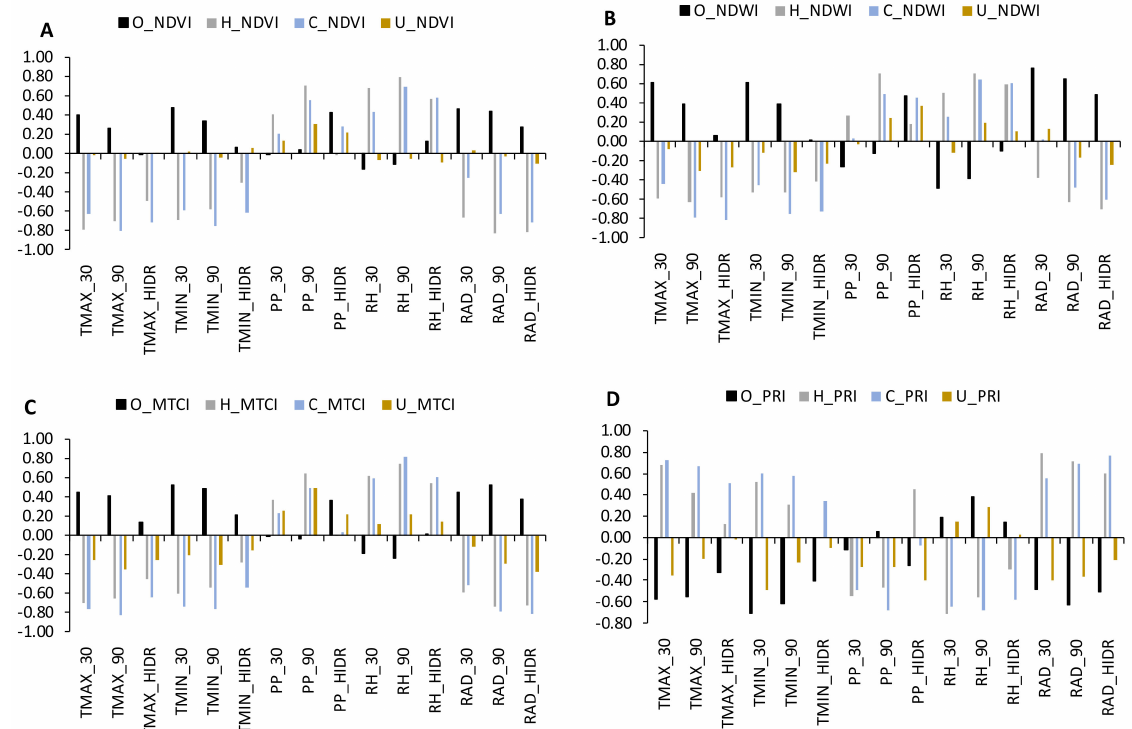
Figure 8. Pearson’s correlation coefficients (r) between vegetation indices NDVI ( A ), NDWI ( B ), MTCI ( C ) and PRI ( D ) and climate variables (TMAX–maximum temperature ( ◦ C); TMIN–minimum temperature ( ◦ C); PP–precipitation (mm); RH–relative humidity (%); and RAD–global radiation (Wm − 2 )), aggregated for different time periods: 30 days (30 d), 90 days (90 d) and the hydrological year (HIDR). Different colors indicate different vegetation type: cork oak (O), herbaceous vegetation (H) and shrubs– Cistus salvifolius (C) and Ulex airensis